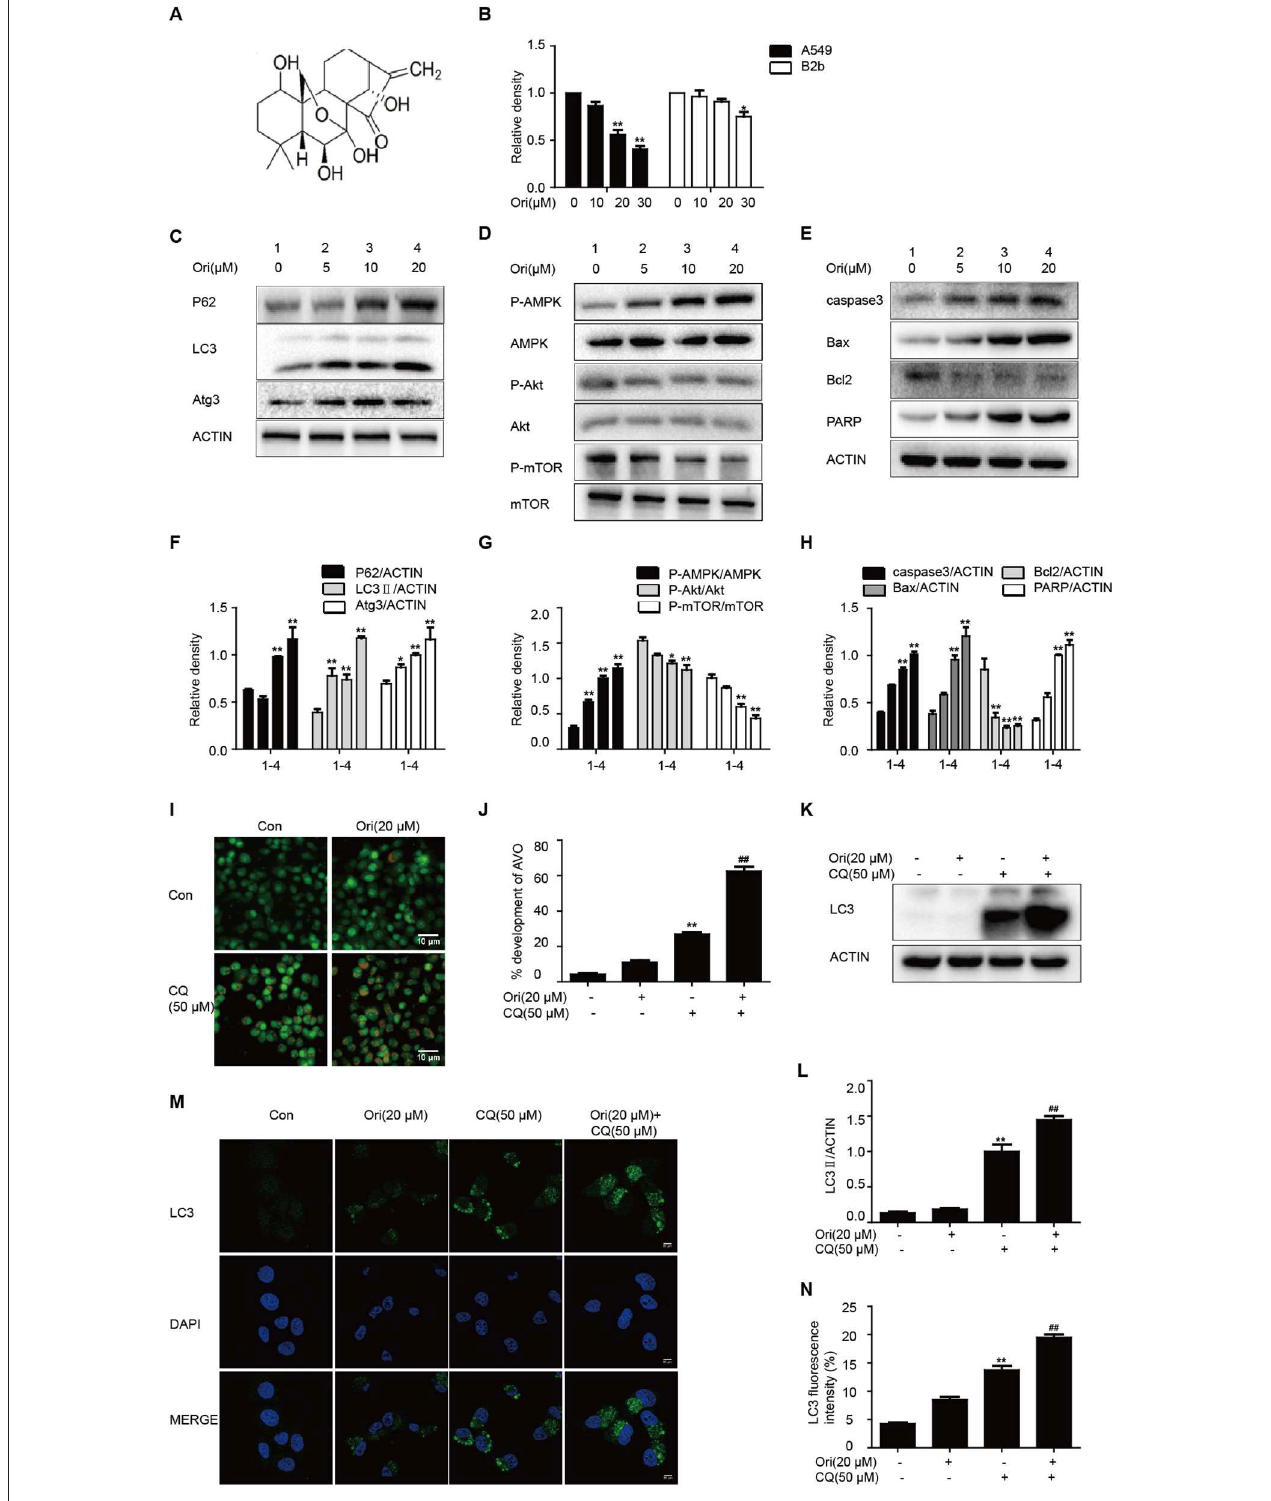
FIGURE 1 | Ori regulates autophagy, AMPK, Akt/mTOR signaling and apoptosis. (A) The structure of Oridonin (Ori). (B) A549 cells and B2b cells were treated with different doses (10, 20, and 30 µ M) of Ori for 18h. Cell viability was calculated as the percentage relative to untreated cells which were considered as